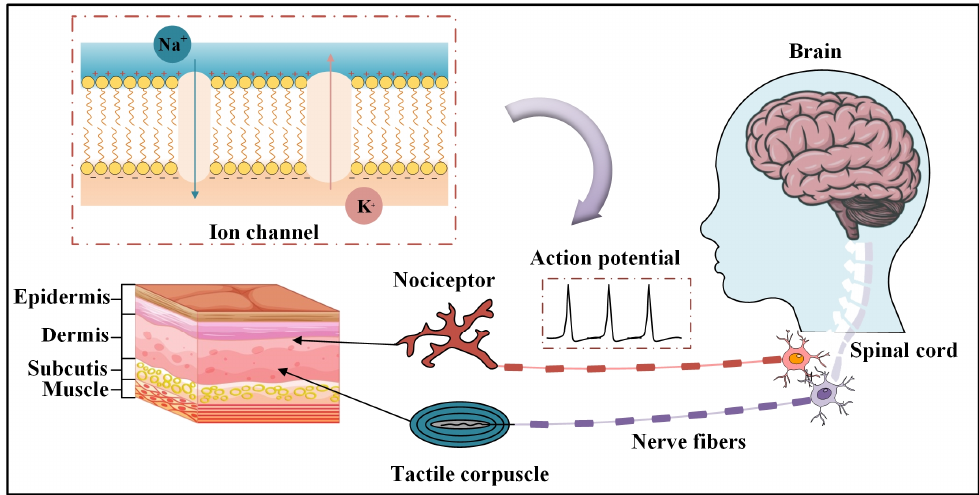
Figure 1. Schematic diagram of the mechanical-electrochemical transduction pathway of the recep-